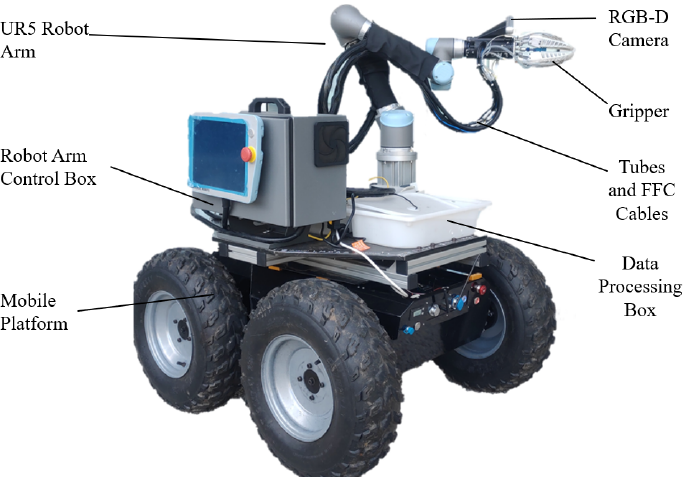
Figure 11. The integrated apple harvesting